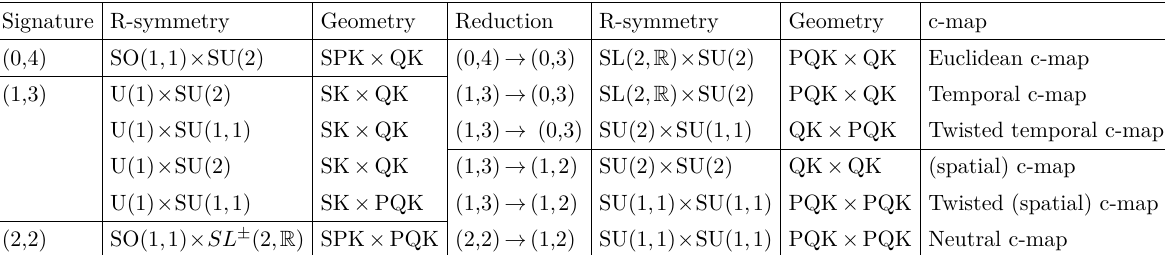
Table 3 . Dimensional reduction from four to three dimensions for all inequivalent signatures: R-symmetry groups, scalar geometries, and type of